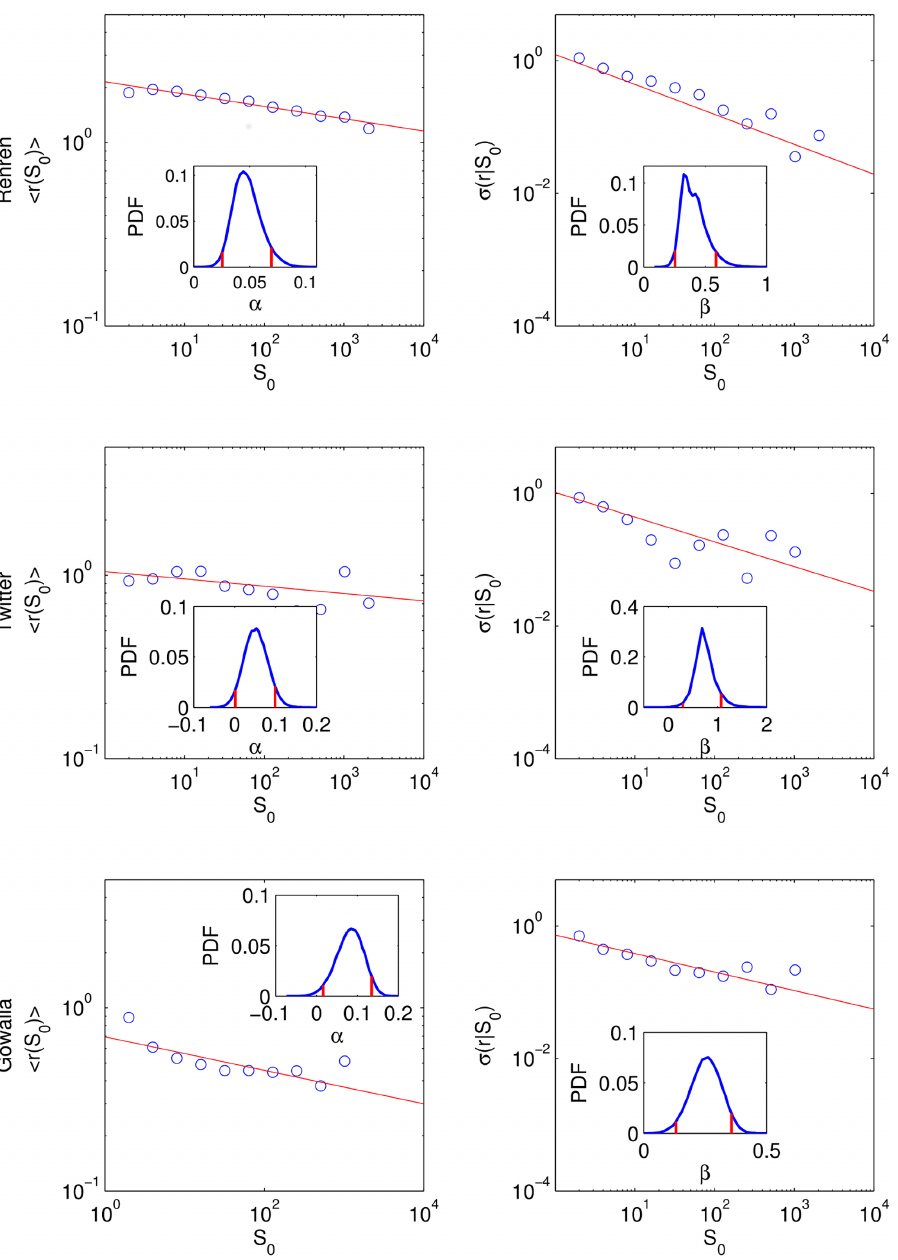
Figure 1. Scaling in average growth rate and standard deviation. Both S r ( S 0 ) T and s ( r D S 0 ) as a function of the initial population size S 0 exhibit a power law, S r ( S 0 ) T * S { a , s ( r D S 0 ) * S { b . Renren: S r ( S 0 ) T * S { 0 : 07 0 0